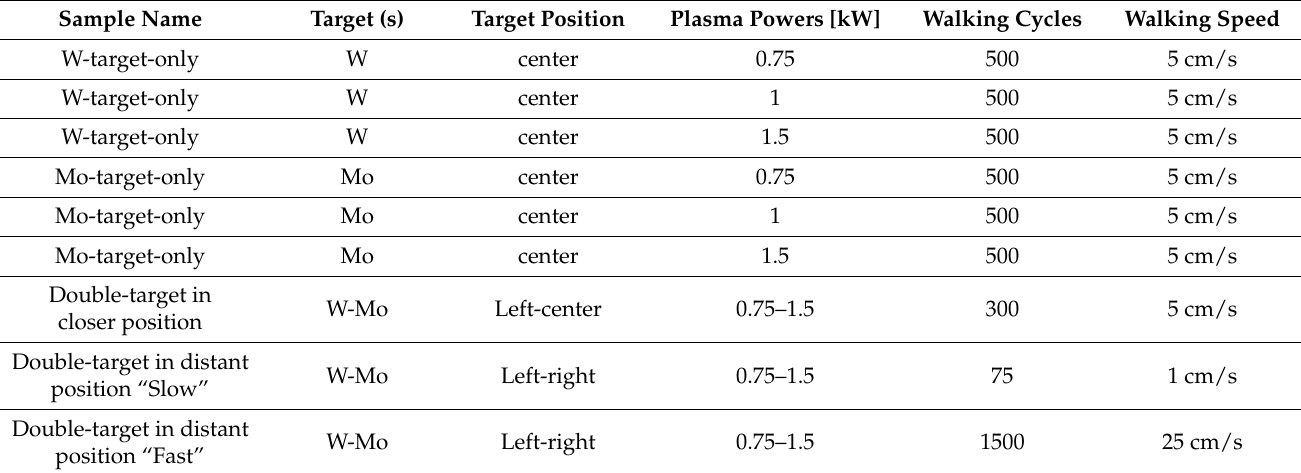
Table 1. Summary of the sample fabrication